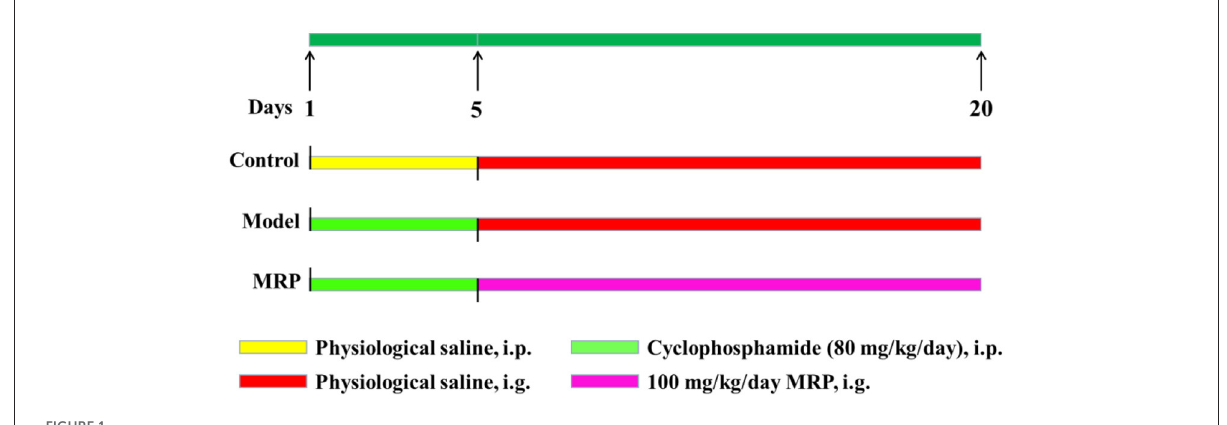
FIGURE1 The experimental protocol was performed in the present study.